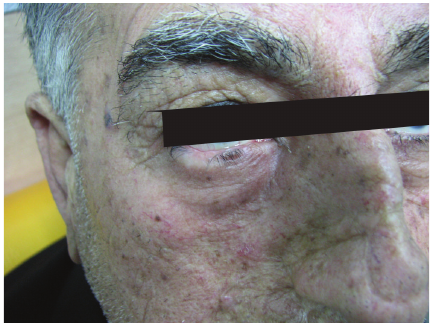
Figure 4: Six months after laser